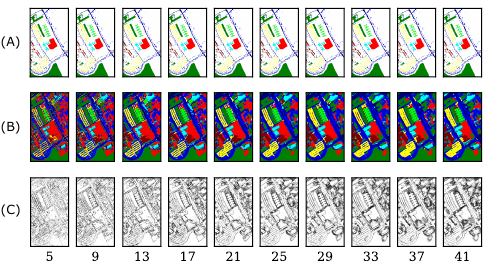
Figure 7. Classification results in different M based on